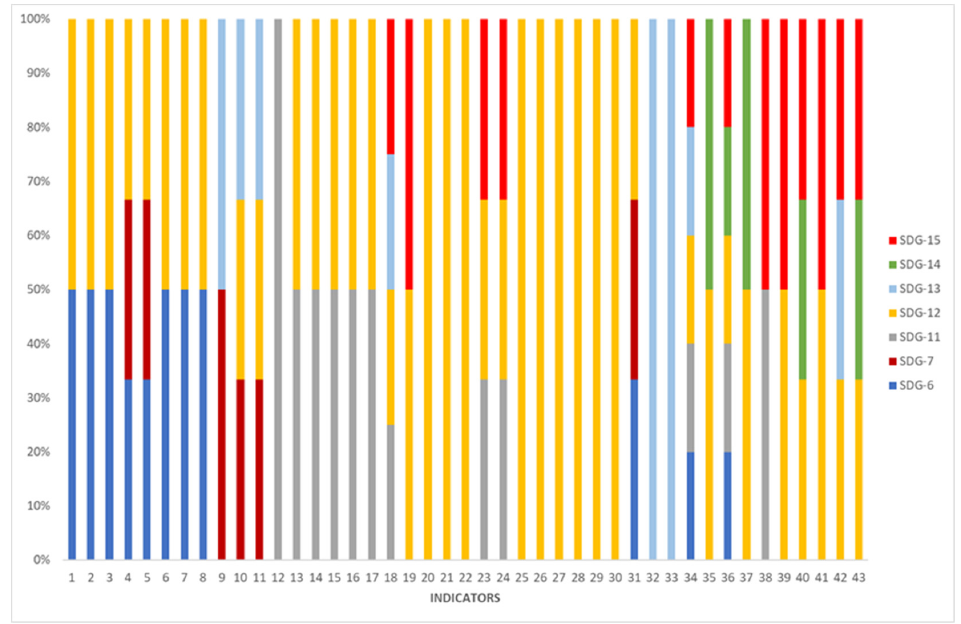
Figure 1. Contribution of the indicators to each SDG assessed on the